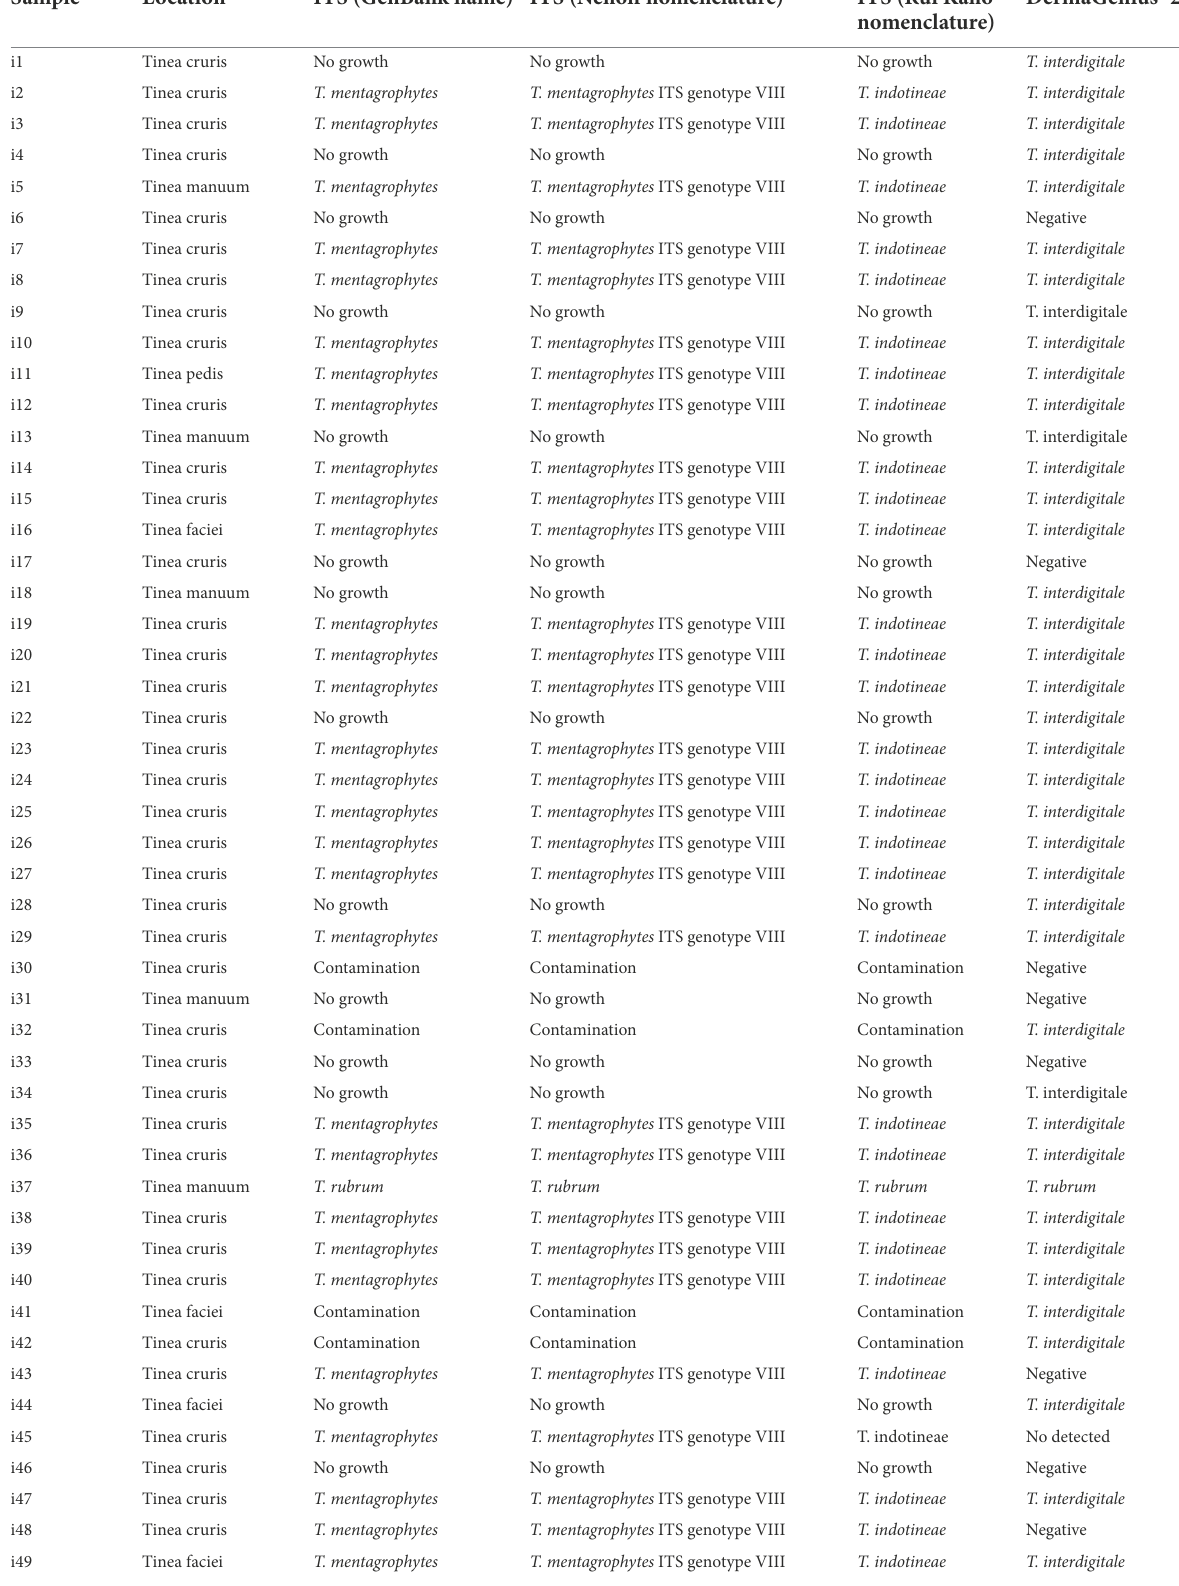
TABLE 1 Direct culture ITS sequencing and DermaGenius 2.0 PCR results obtained from 49 skin/hair specimens from India. Sample Location ITS (GenBank name) ITS (Nenoff